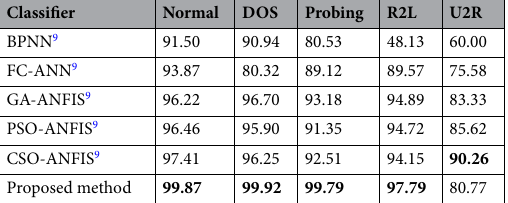
Table 10. Comparison of accuracy on KDDTrain+ dataset. Significant values are in bold.